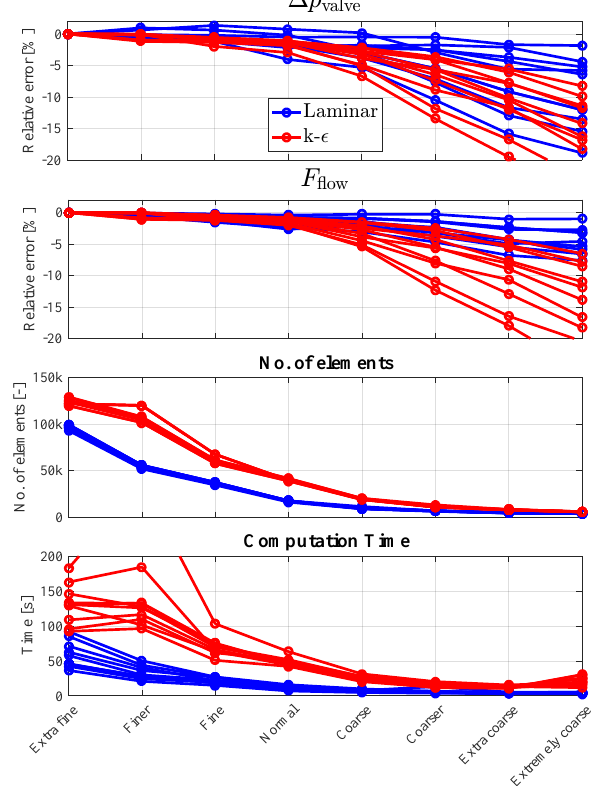
Figure 7: Relative errors, number of elements and com- putation time for 10 design points randomly sampled throughout the design space for both the Laminar and k- (cid:15) CFD